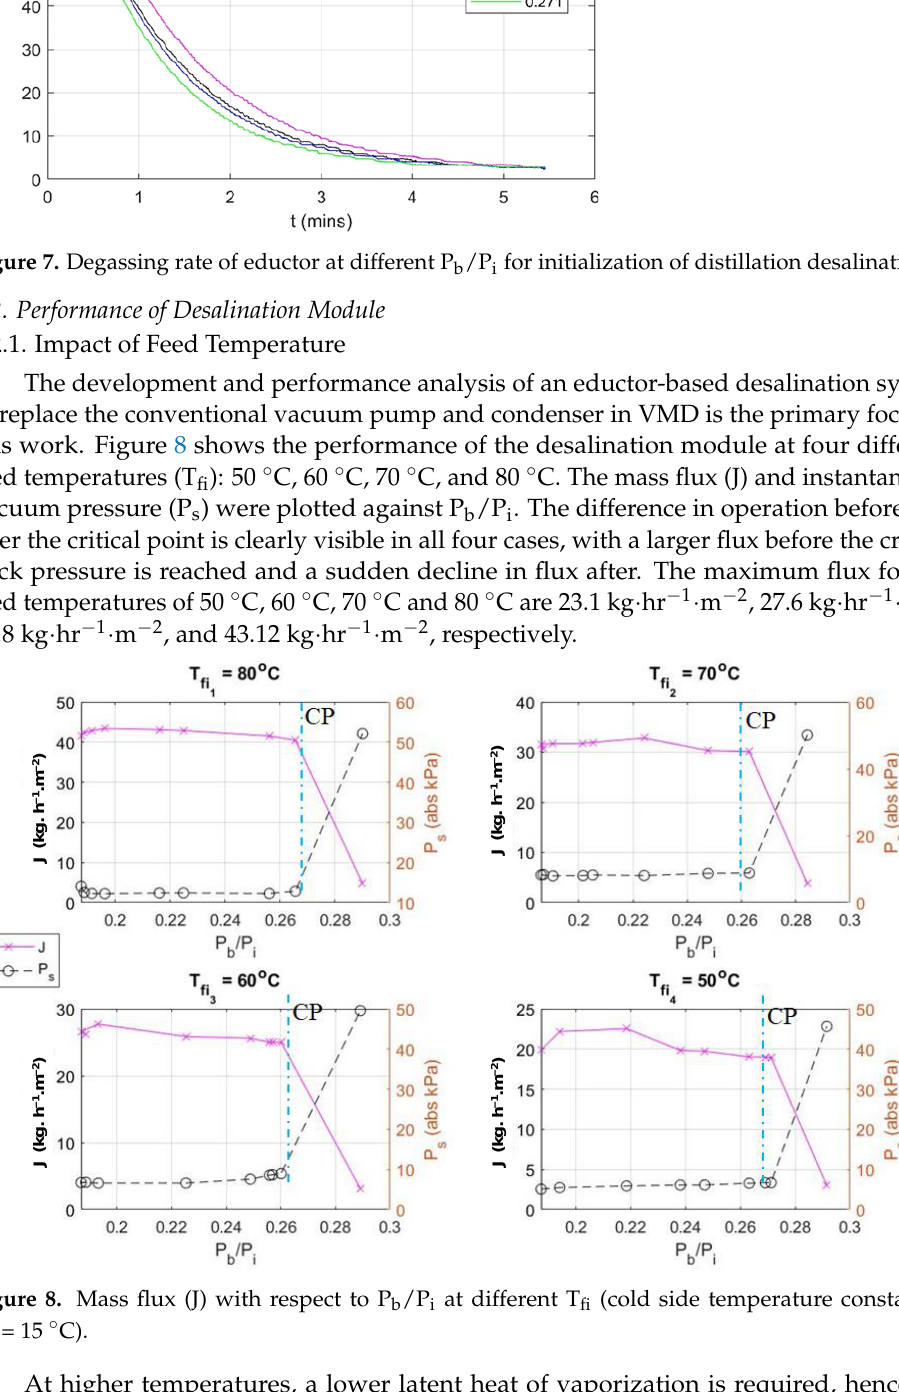
Figure 8. Mass flux (J) with respect to P b /P i at different T fi (cold side temperature constant at T p = 15 °C).